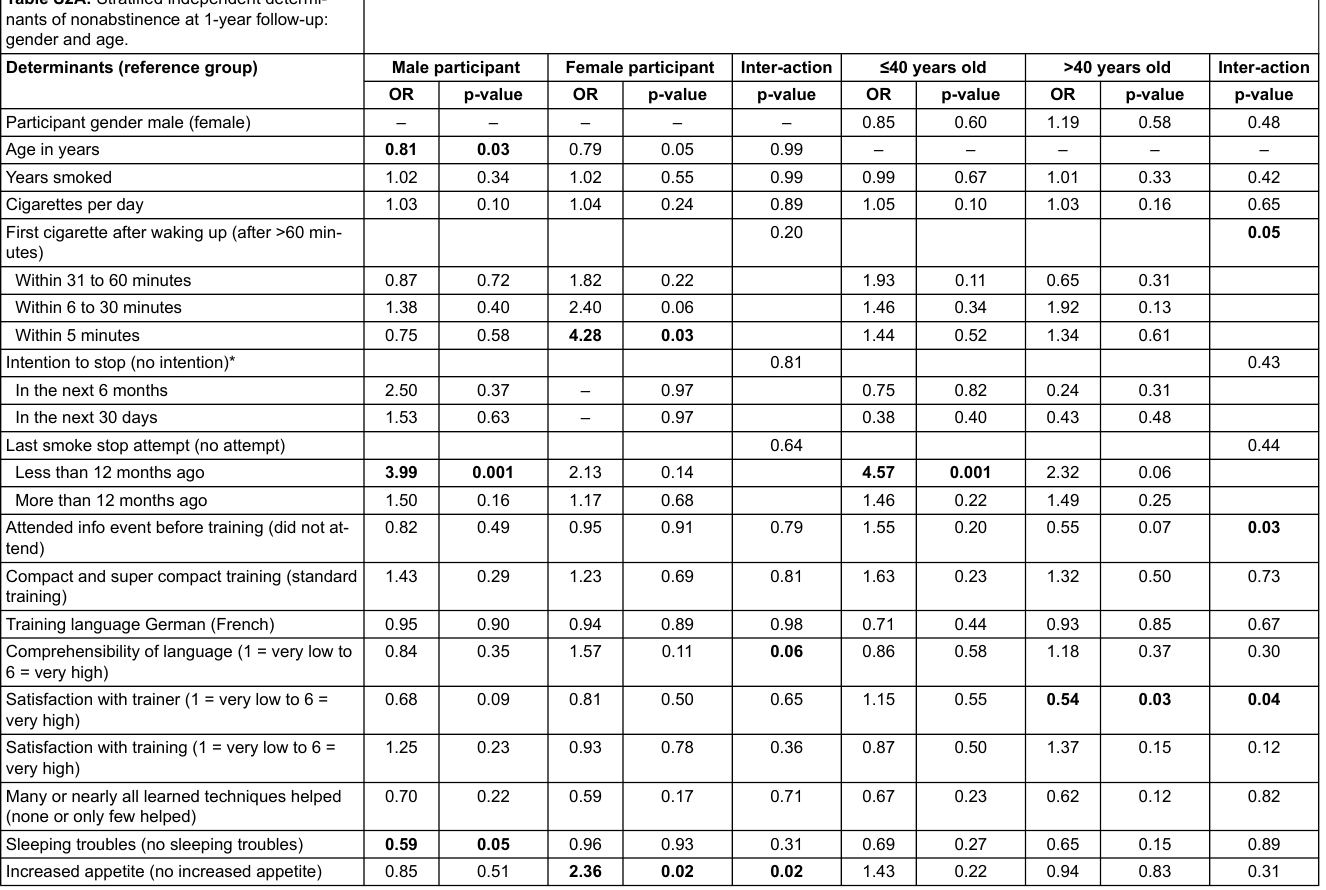
Table S2A: Stratified independent determi- nants of nonabstinence at 1-year follow-up: gender and